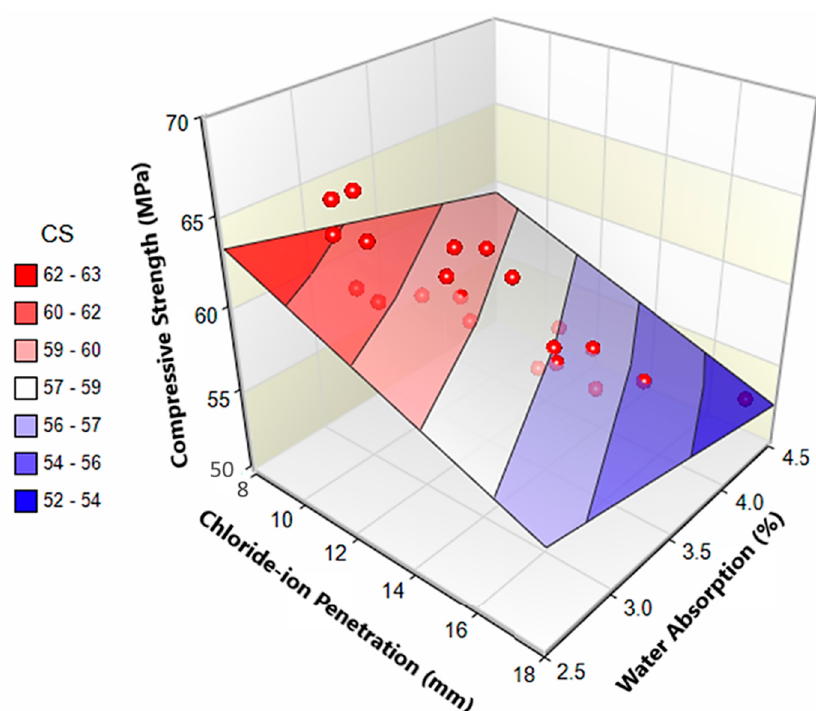
Figure 15. Correlation between CS, CIP and WA.